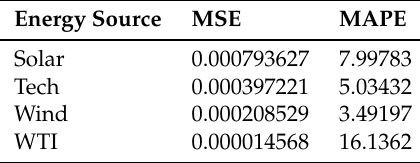
Table 3. Mean square error (MSE) and mean absolute percentage error (MAPE) for the four indices considered.